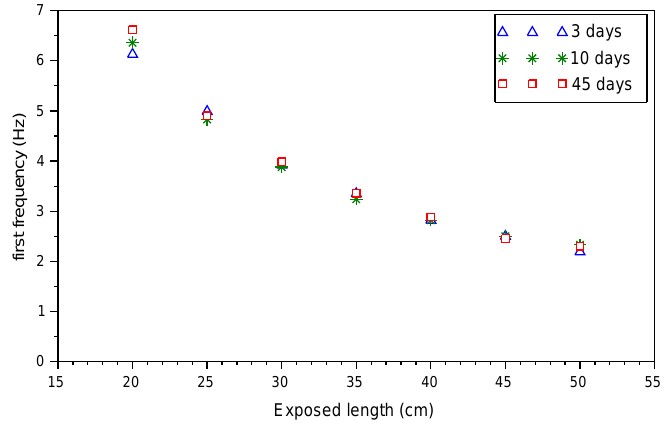
Figure 4. Variation of first frequency with exposed length H in the clayey soil after 3, 10 and 45 resting days.